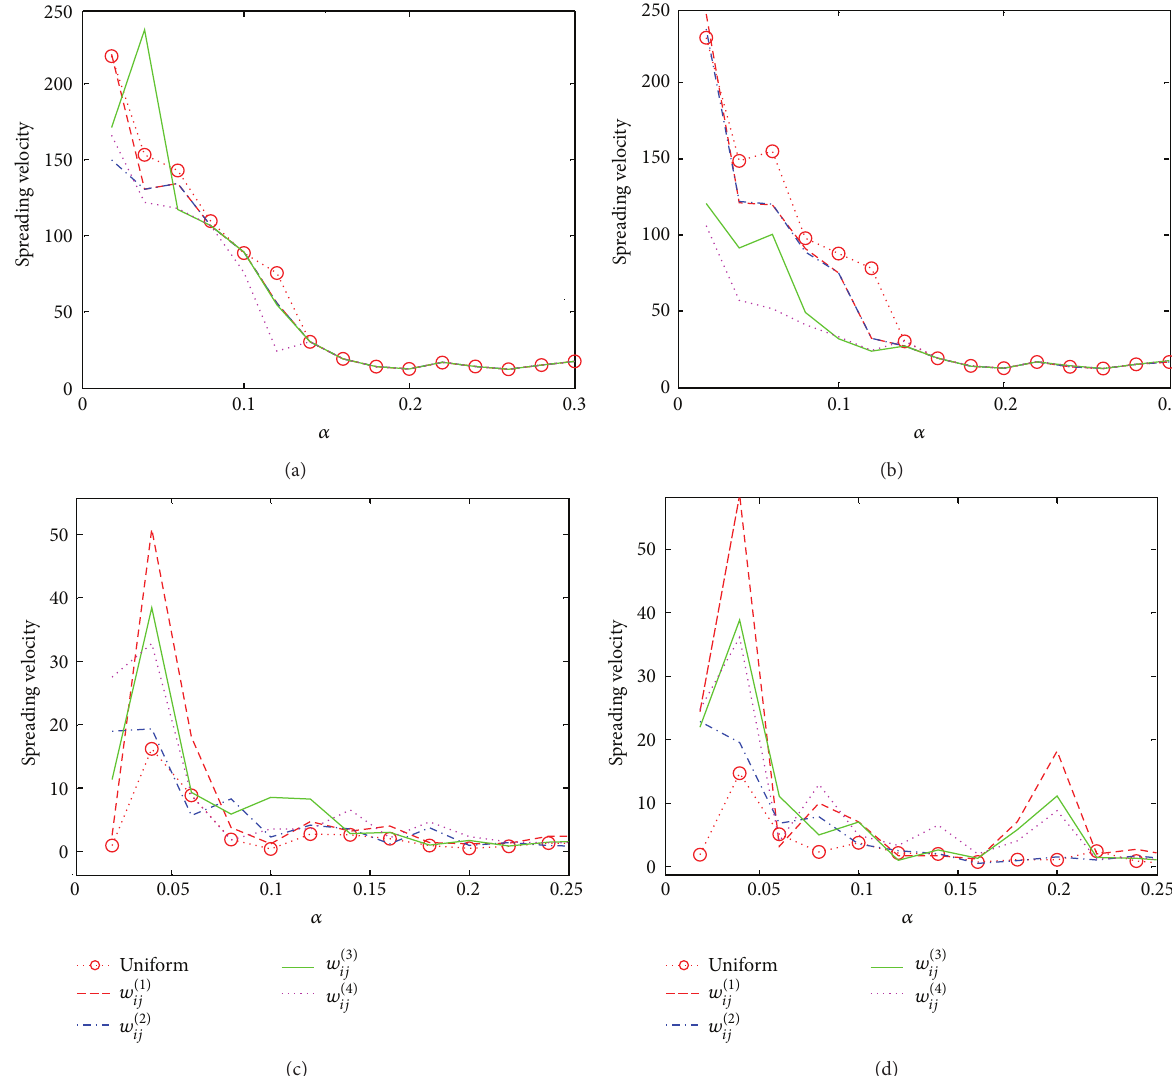
Figure 4: After the cascade stops, the spreading velocity 𝑉 of failures in SF network as a function of 𝛼 for different strategies with (a) 𝜏 = 20 under HL attack, (b) 𝜏 = 100 under HL attack, (c) 𝜏 = 20 under RA attack, and (d) 𝜏 = 100 under RA attack, respectively. Here (c) and (d) are averaged over 20